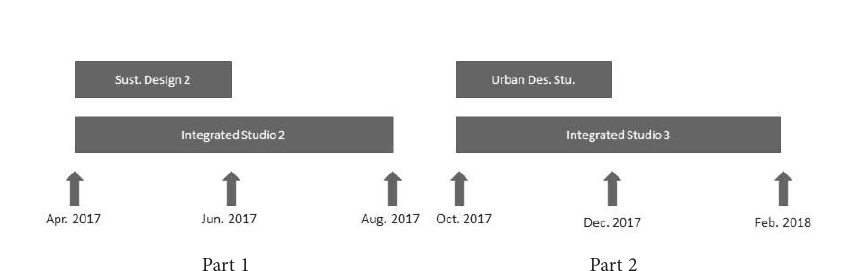
Figure 4. Study parts concerning EVD year 2 students’ academic context